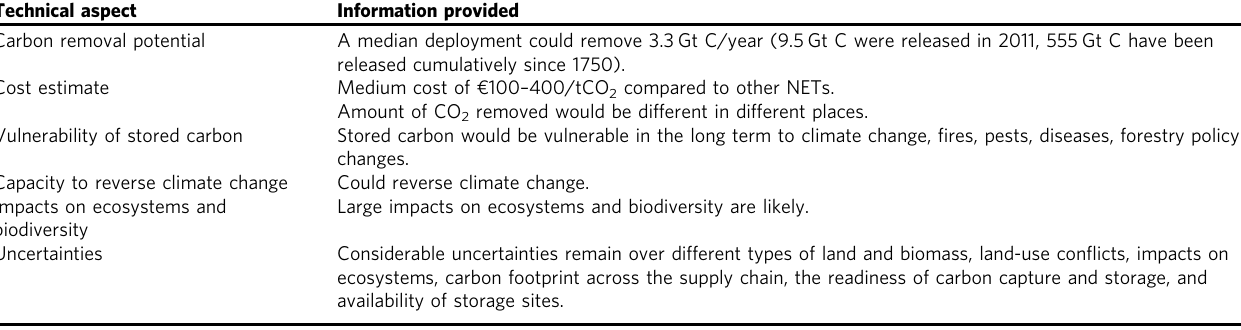
Table 3 Additional technical information on bioenergy with carbon capture and storage a